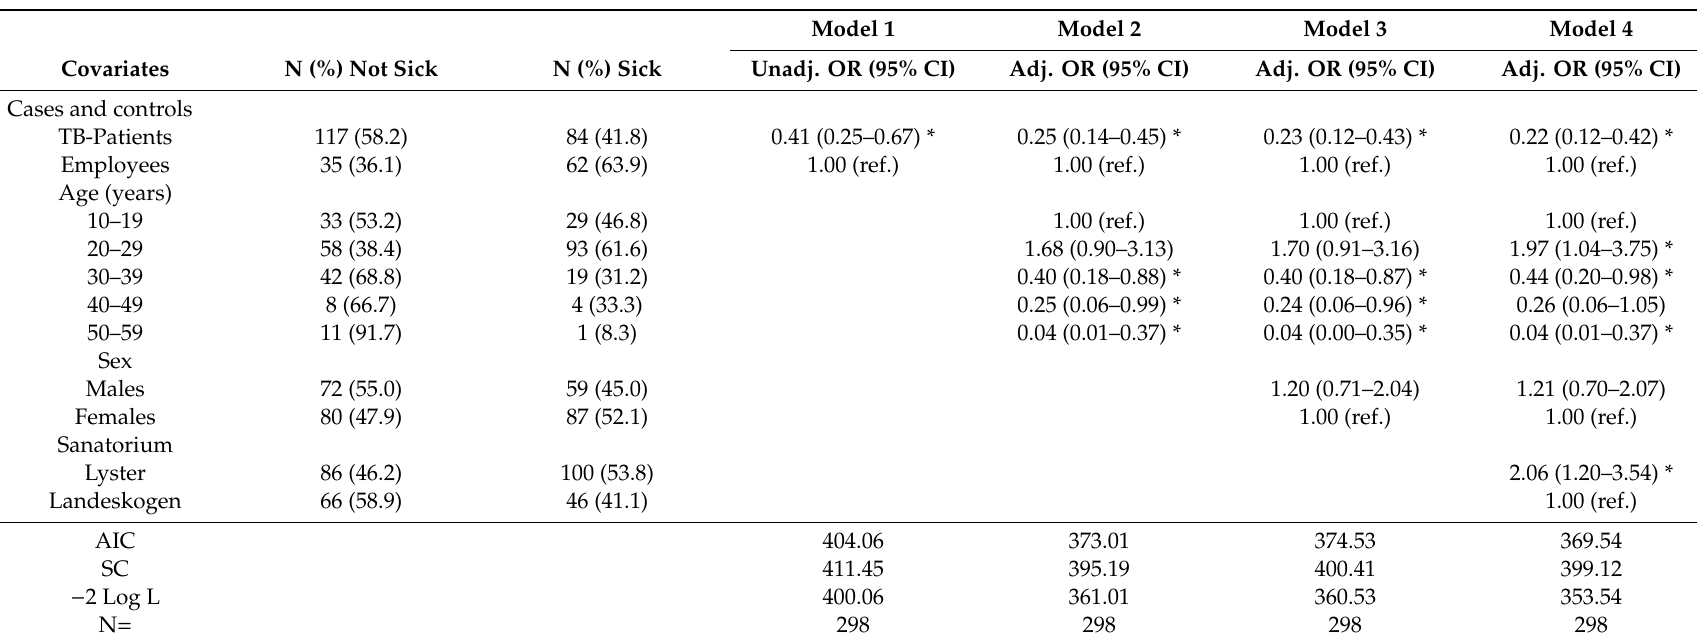
Table 3. Share and relative odds (with 95 percent confidence intervals) of having an ILI by TB status, age, sex, and